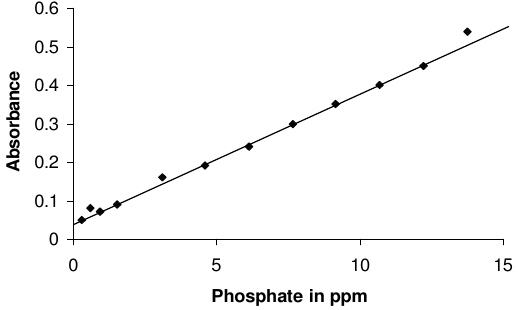
Figure 1 . Calibration graph for the determination phosphate under optimized experimental